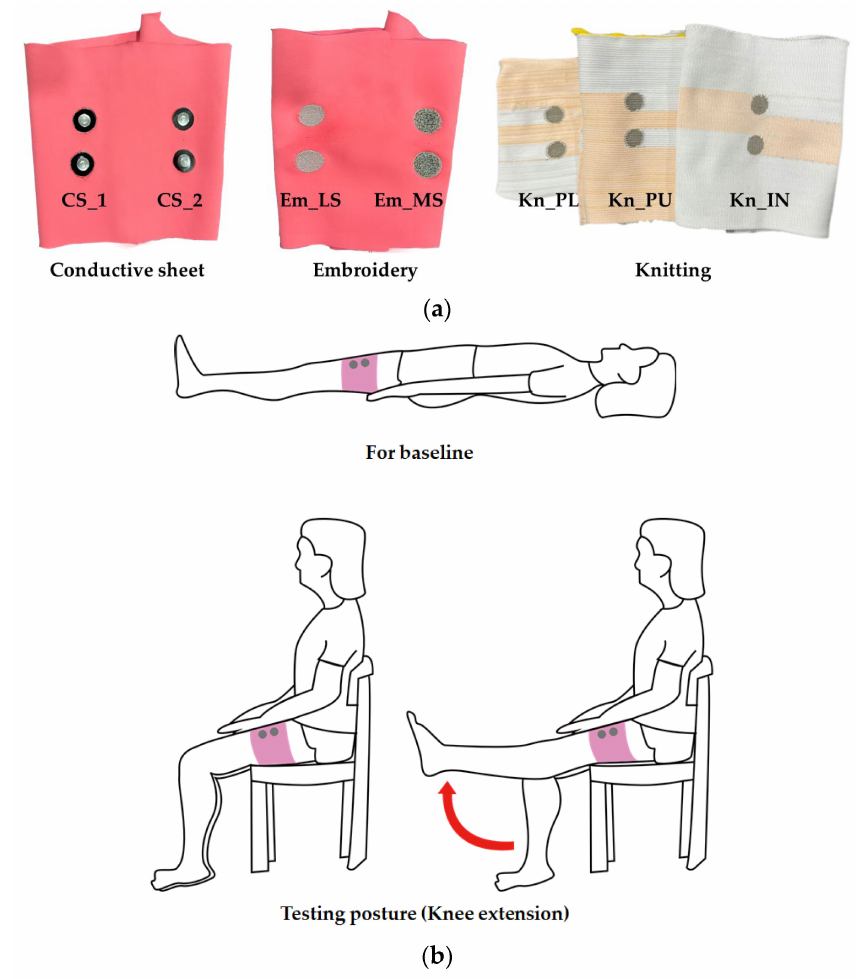
Figure 3. Images for measuring the sEMG signal: ( a ) actual leg sleeve; ( b ) testing